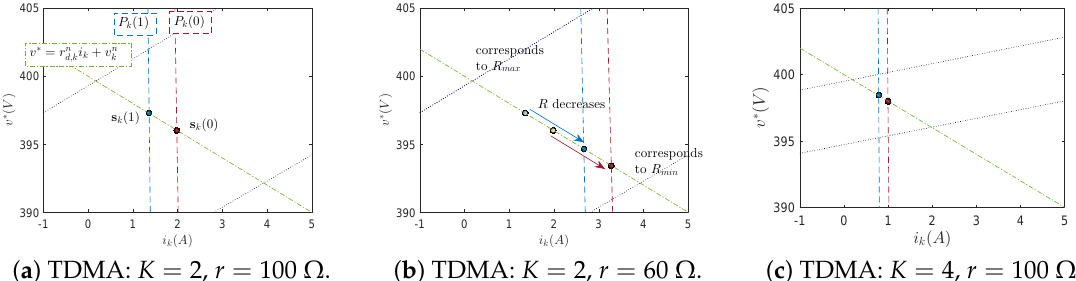
Figure 10. The detection space of VSC j , fixed r d constellation, γ = 0.2, Q = 2 and resistive load r . The dashed lines represent the output power P j = v ∗ i j , and the dashed-dotted line v ∗ = − r d , j i j + v j represents the symbol x j that VSC j is inserting. The loci of output symbols s j are on the intersection between the lines corresponding to output powers and the local inputs. As r varies, s j slide along the dashed-dotted lines between the bounds (dotted lines) defined by operational constraints on the